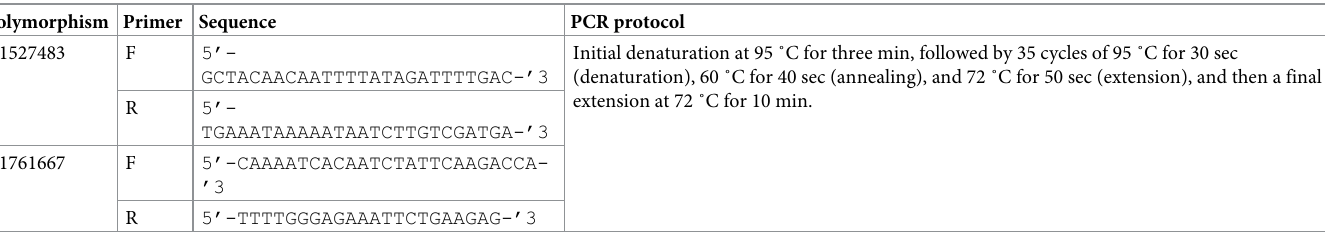
Table 13. Primer sequences for CD36 polymorphisms, and PCR amplification